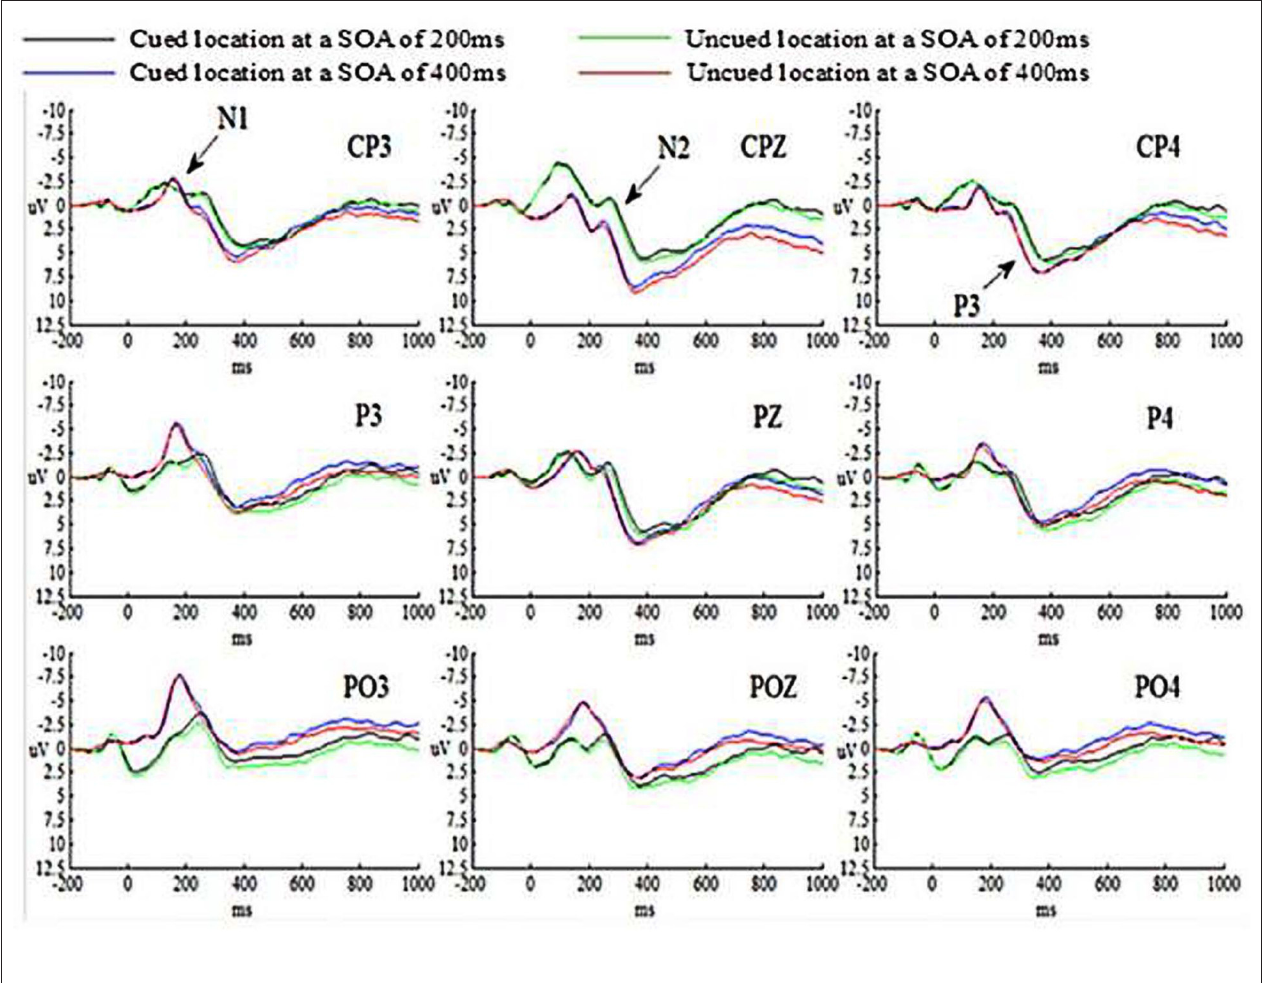
FIGURE 3 | Grand-averaged ERP waveforms for the emergency managerial experts in Experiment